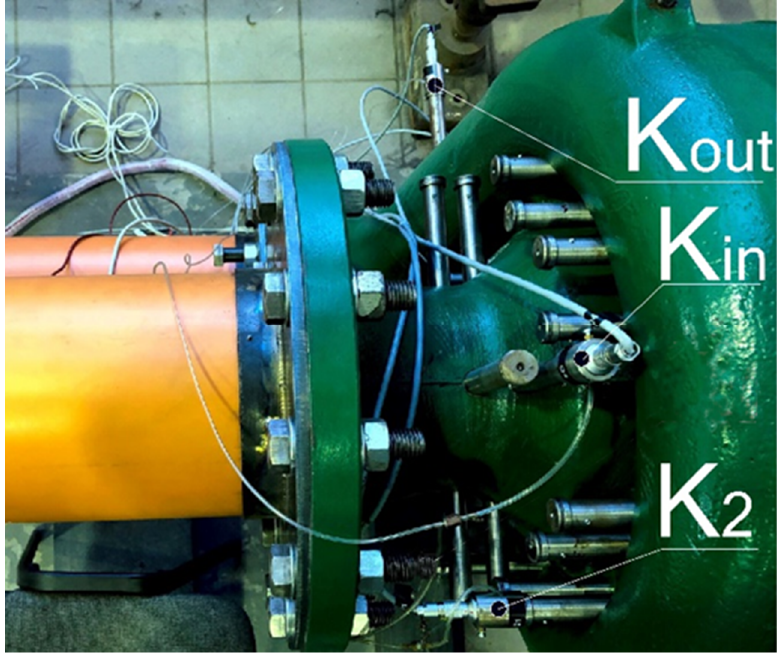
Figure 2. Illustration showing the high-response Kulite pressure transducers’ locations.